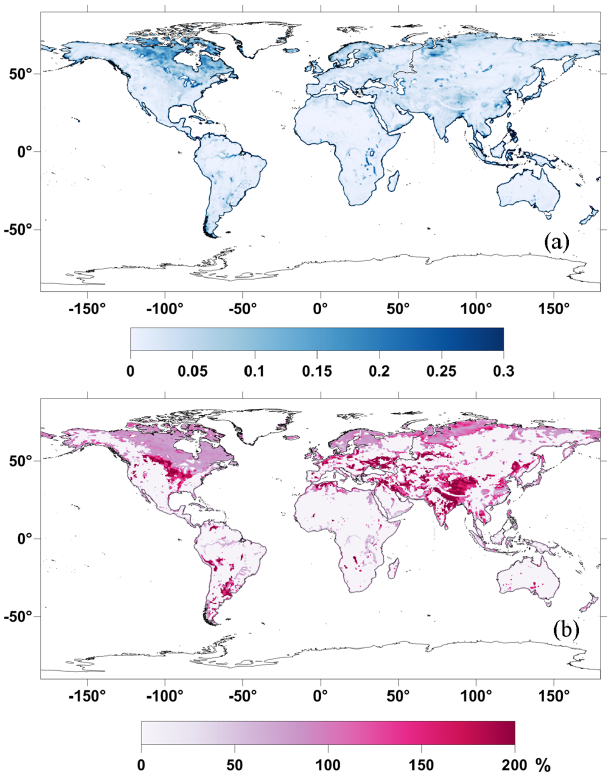
Figure 3. LPDR fractional water mean (a) and 2 times the coeffi- cient of variation (b) over the years 2003–2010 and 2013–2015.